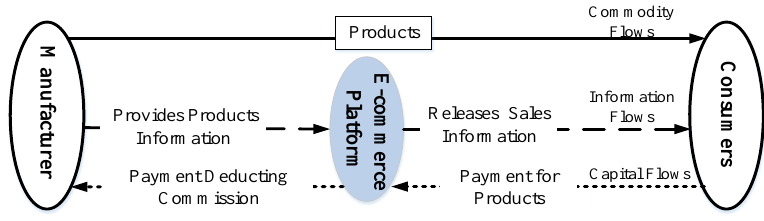
Figure 1. The model structure.